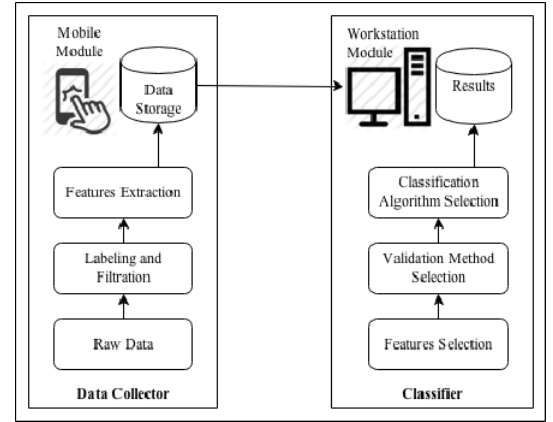
Fig. 1. The proposed